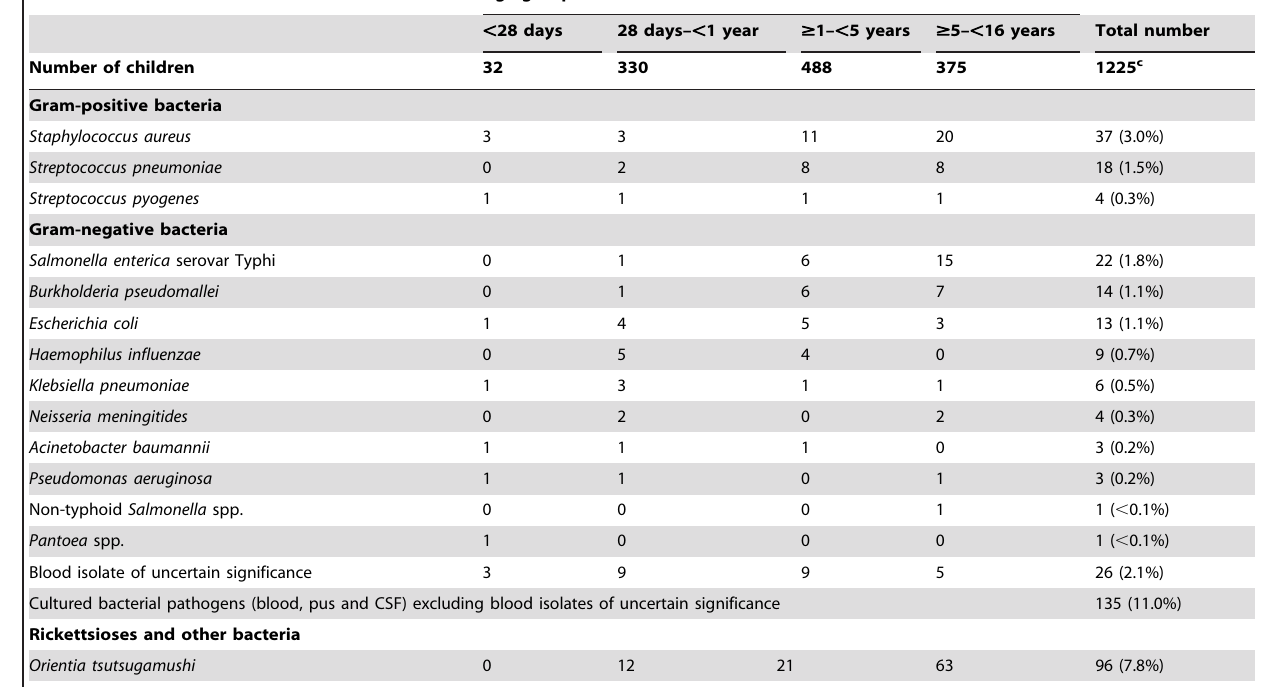
Table 3. Microbiological